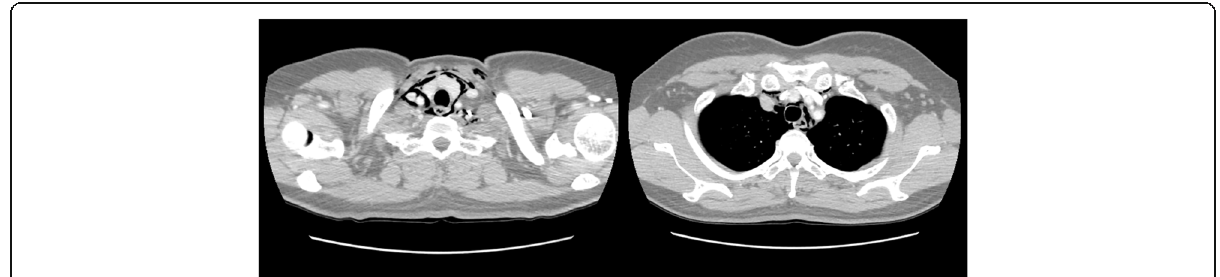
Fig. 4 Chest computed tomography revealing emphysema extending to the mediastinum